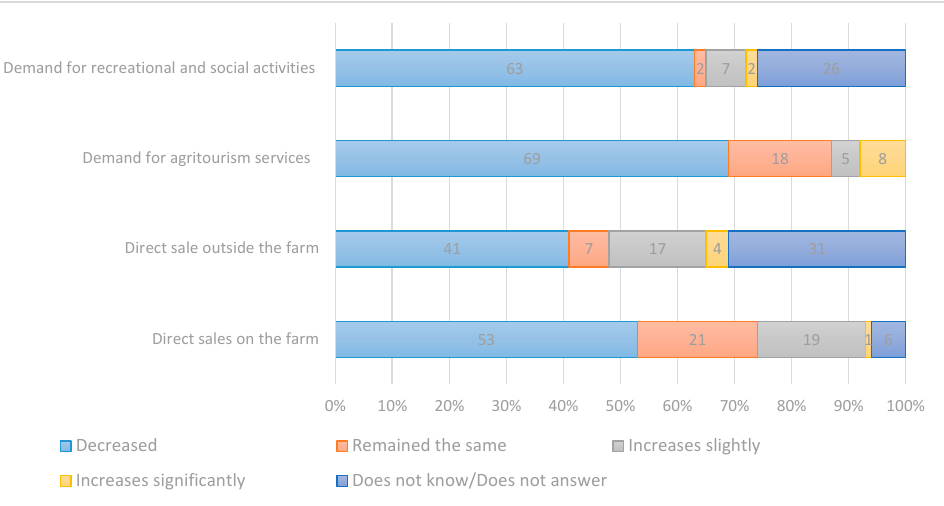
Figure 8. Effects on demand observed in the farm compared to 2019 (values in %) (author: our elaboration).